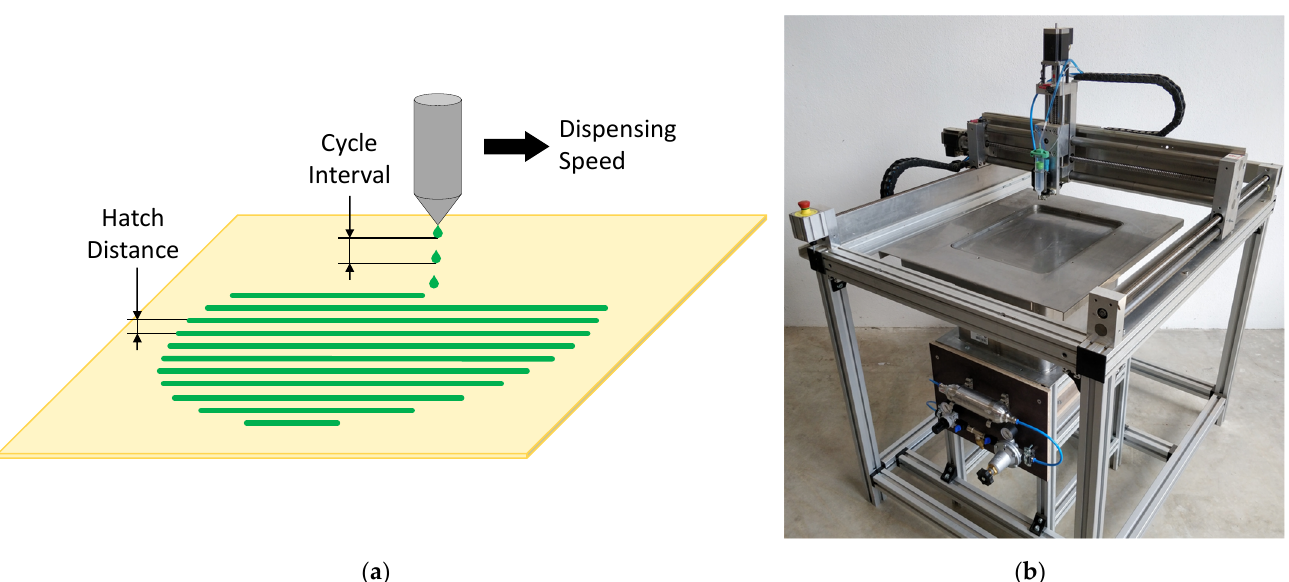
Figure 4. ( a ) Schematic of the dispensing pattern and digitally adjustable process parameters; ( b ) image of the dispensing device.